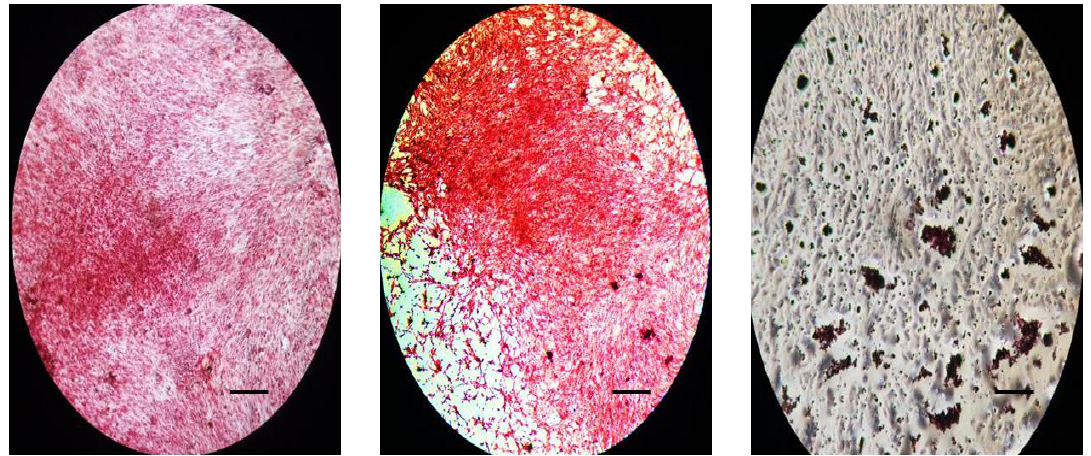
Figure 2. Tri-lineage di ff erentiation potential of MSCs. Osteogenesis, chondrogenesis and adipogenesis of MSCs were evaluated by Alizarin red, Safranin-O and Oil Red-O staining, respectively, after 21 days induction. Scale bar: 1 mm.